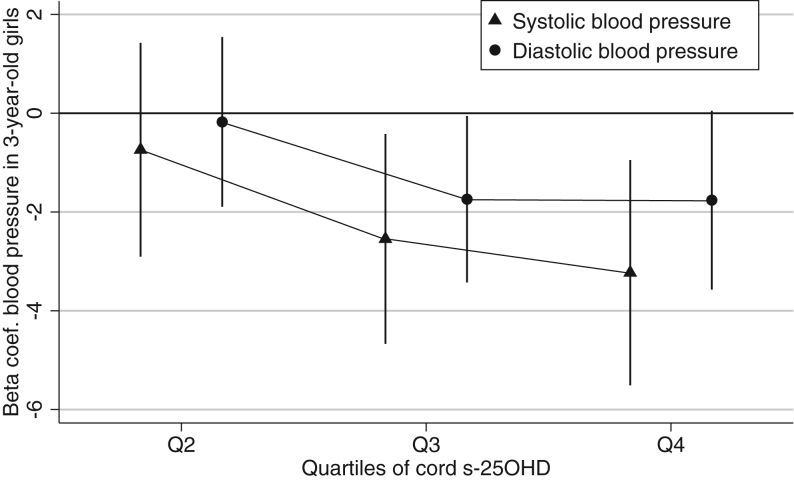
Adjusted associations of s-25OHD divided by quartiles with SBP and DBP in 3-year-old girls from Odense Child Cohort. The multiple linear regression model was stratified by sex and adjusted for maternal educational level, season of birth and child height, weight and age. Reference: Q1. Coef., Coefficient; Q, quartile; s-25OHD, serum 25-hydroxyvitamin D2+3.